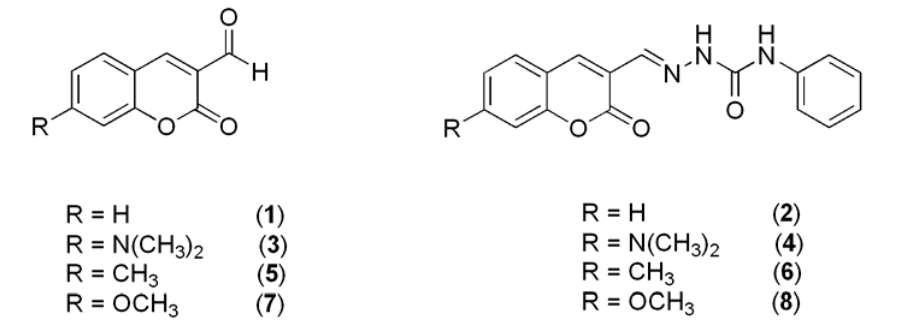
Figure 1. Molecular structure of the studied